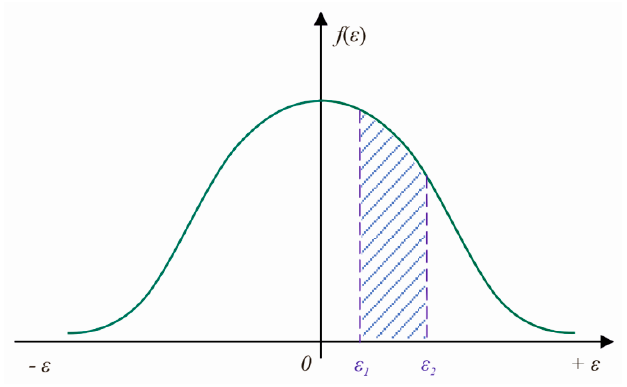
Figure 1. Normal distribution of measurement error (density function).